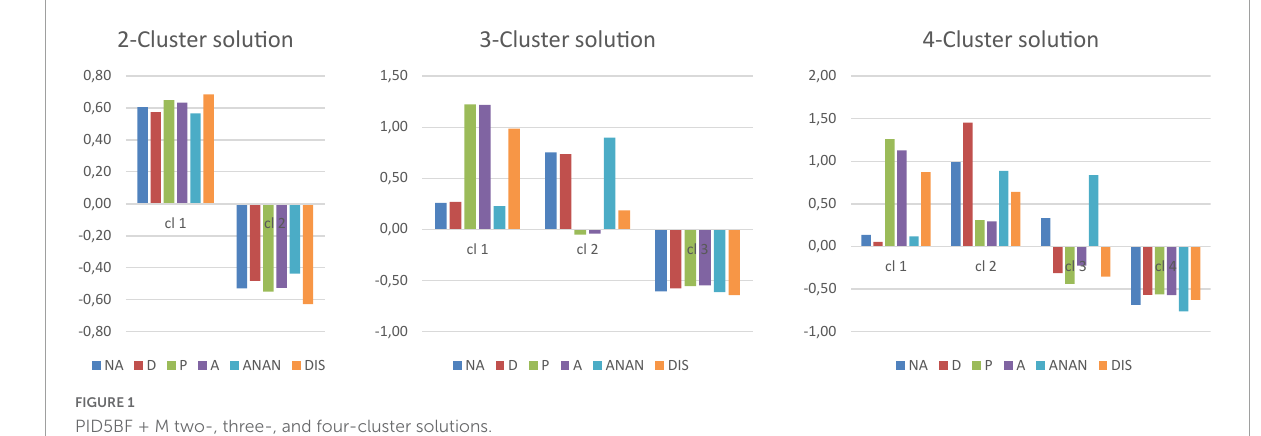
FIGURE1 PID5BF + M two-, three-, and four-cluster solutions.